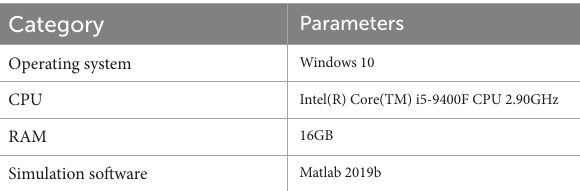
TABLE 3 Table of experimental software and hardware